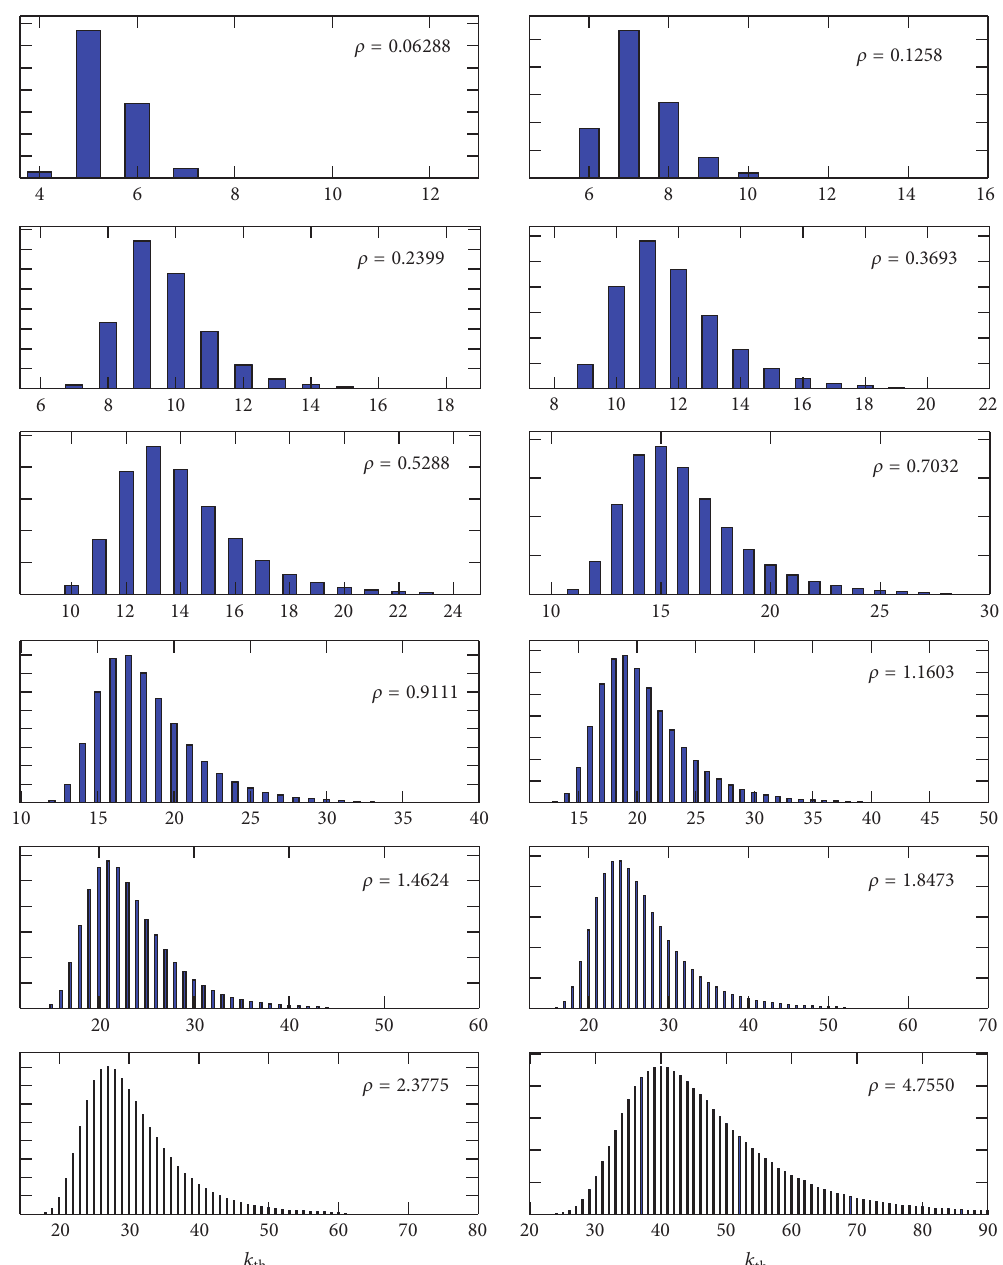
Figure4:MonteCarlosimulationoftheprobabilitymassfunctionoftheparameter 𝑘